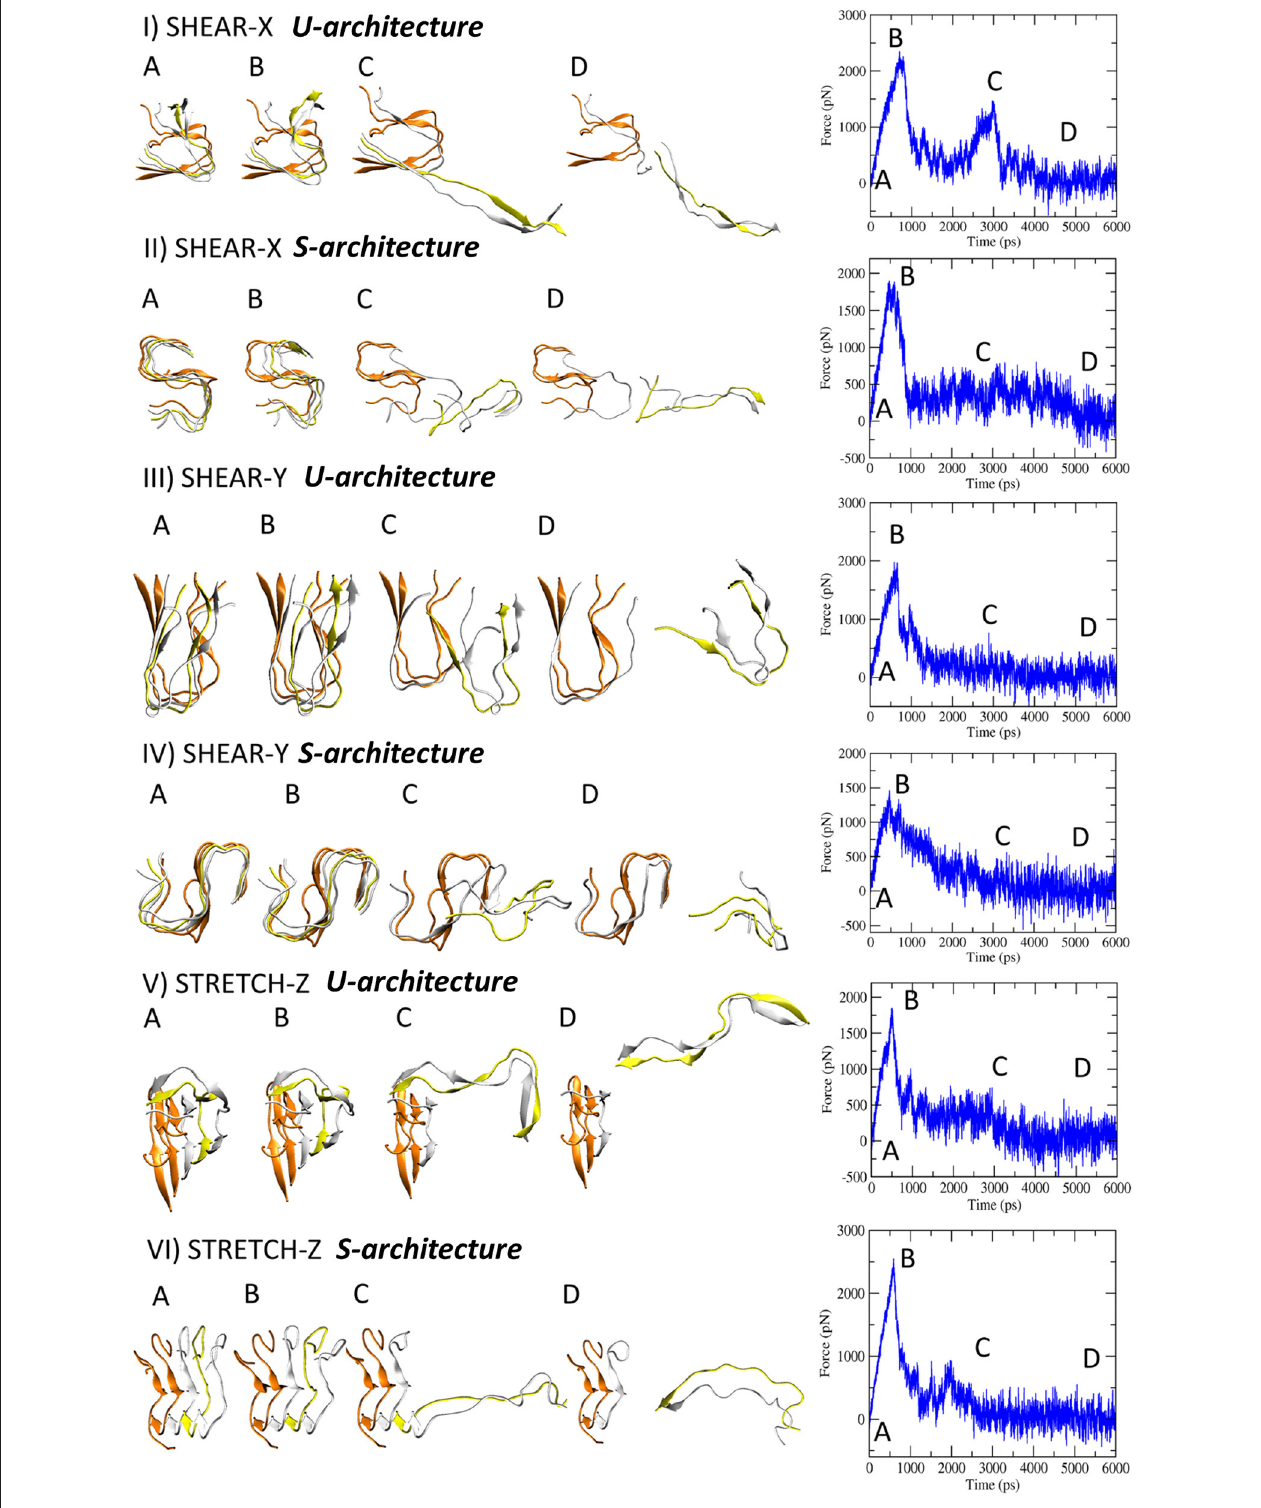
FIGURE 2 | Representative snapshots of U- and S-models evolving in time when the three deformation protocols are applied. On the right side the corresponding force-time profile is plotted.